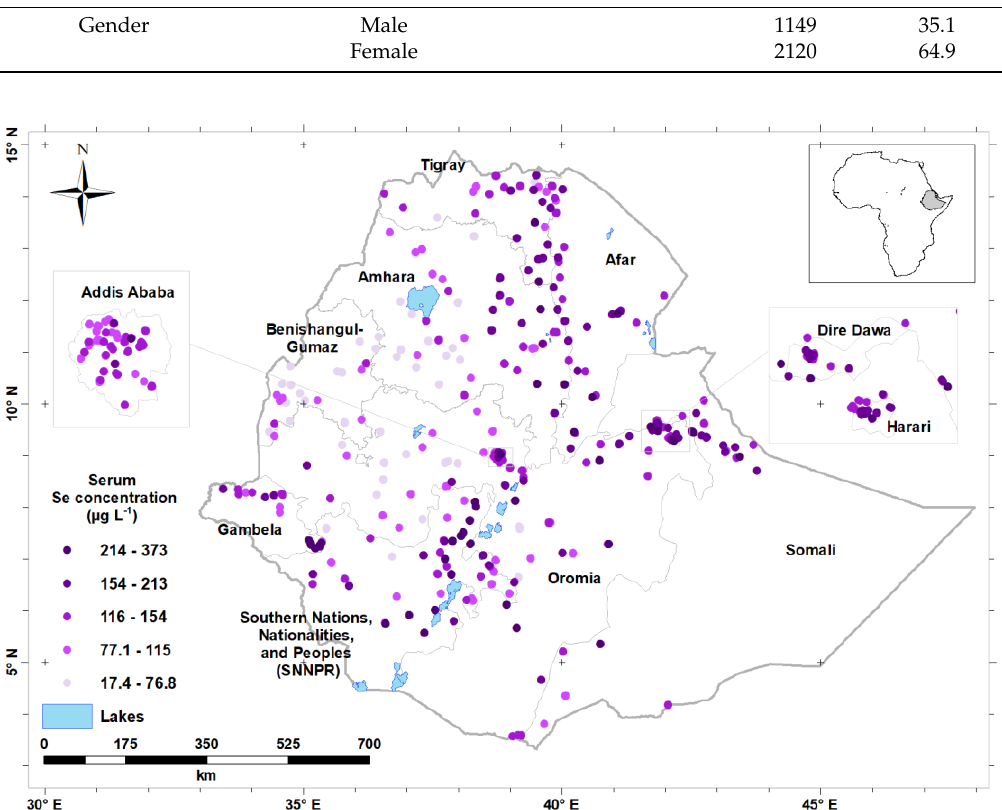
Figure 2. Distribution of mean serum selenium (Se) concentration (by enumeration area) in Ethiopia. Median serum Se concentrations varied by demographic group, being greatest among WRA 103.6 (68.2, 143.0) µg L −1 and smallest among YC 67.2 (41.9, 94.7) µg L −1 (Table 2). Different thresholds of serum Se concentration have been used to define Se deficiency, based on associated expression of Se-containing proteins [8,19]. Serum Se concentration was below a threshold for optimal GPx3 activity [8] in 35.4% of WRA and 42.9% of men. In addition, serum Se concentration was below a threshold for optimal IDI activity [8] in 22.4% of WRA and 28.8% of men. Compared to